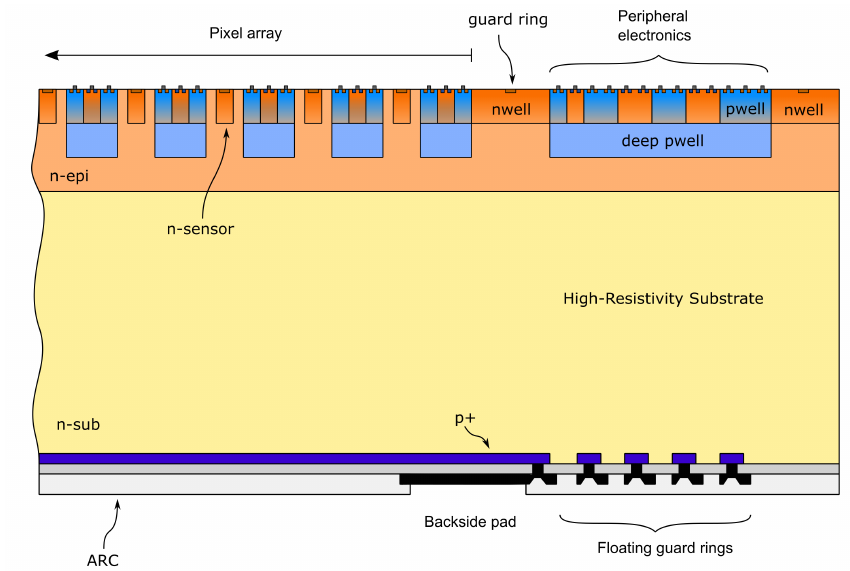
Figure 1. Schematic cross-section of the pixel array with floating backside termination